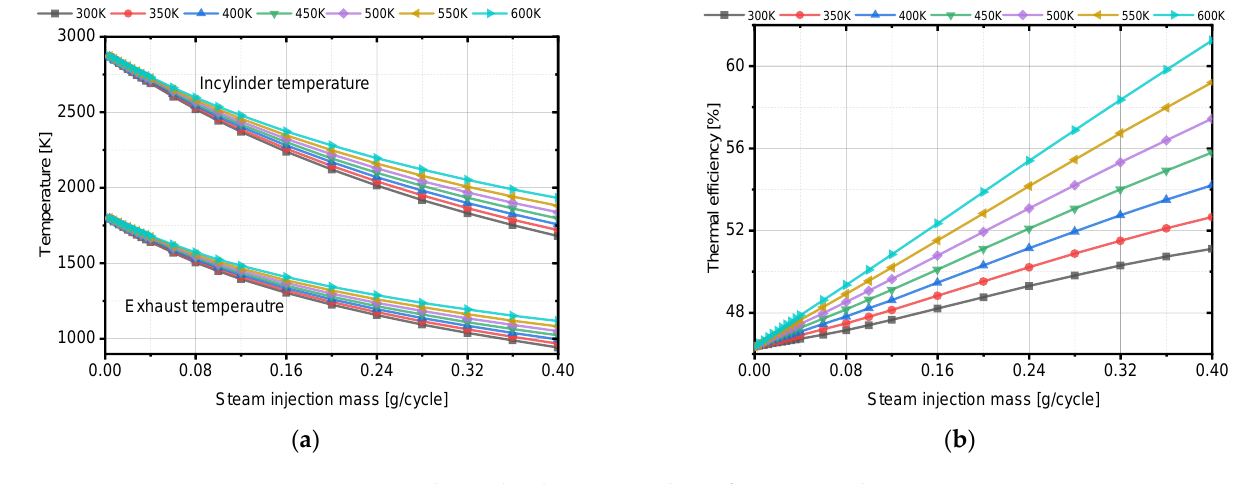
Figure 4. Relationship between cycle performance and steam injection mass at various injection temperatures (P steam = 20 MPa; P inkate = 0.1 MPa; CR = 10). ( a ) In-cylinder/exhaust temperatures; ( b ) Thermal efficiency.